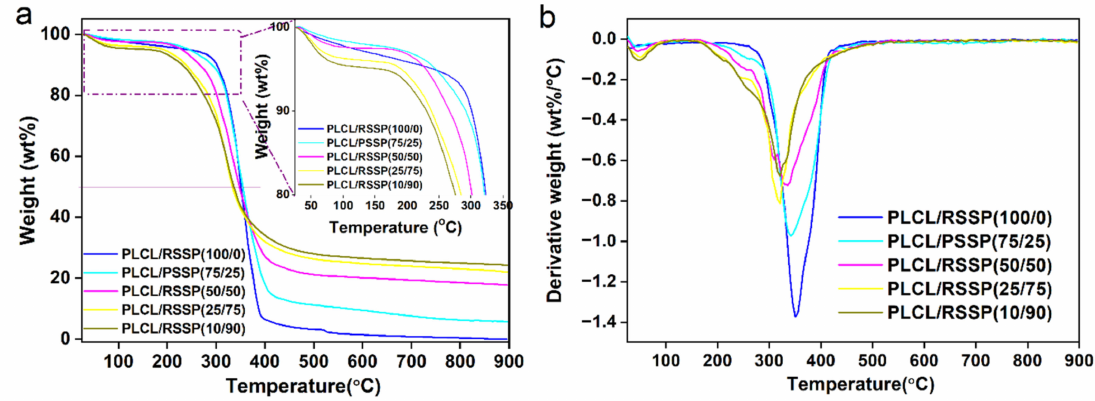
Figure 4. TGA of the PLCL/RSSP nanofibrous membranes. ( a ) TG curves. ( b ) DTG